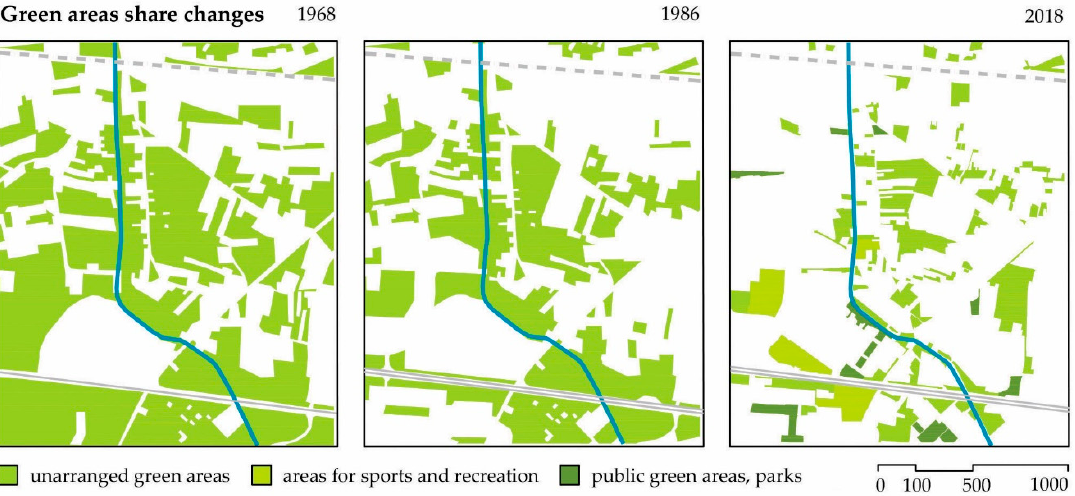
Figure 4. Changes to the existing state of green areas along the Vrapˇcak stream. Source: